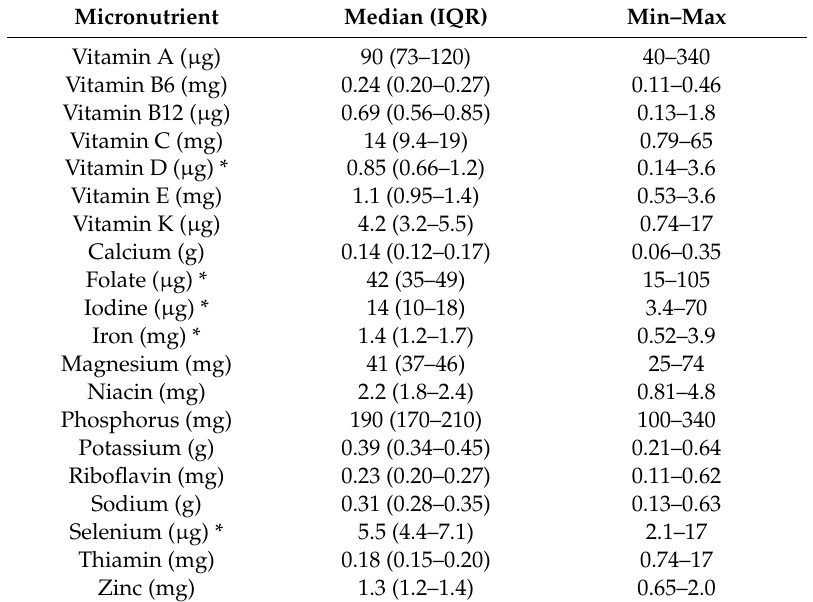
Table 4. Dietary intakes of micronutrients per day, adjusted per MJ ( N =